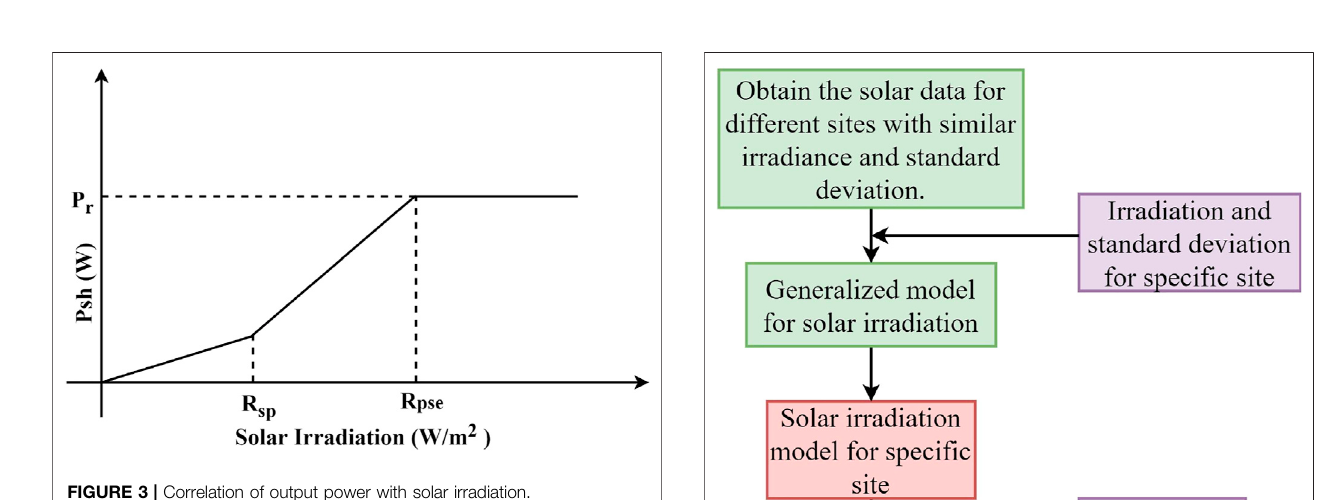
FIGURE 3 | Correlation of output power with solar irradiation.